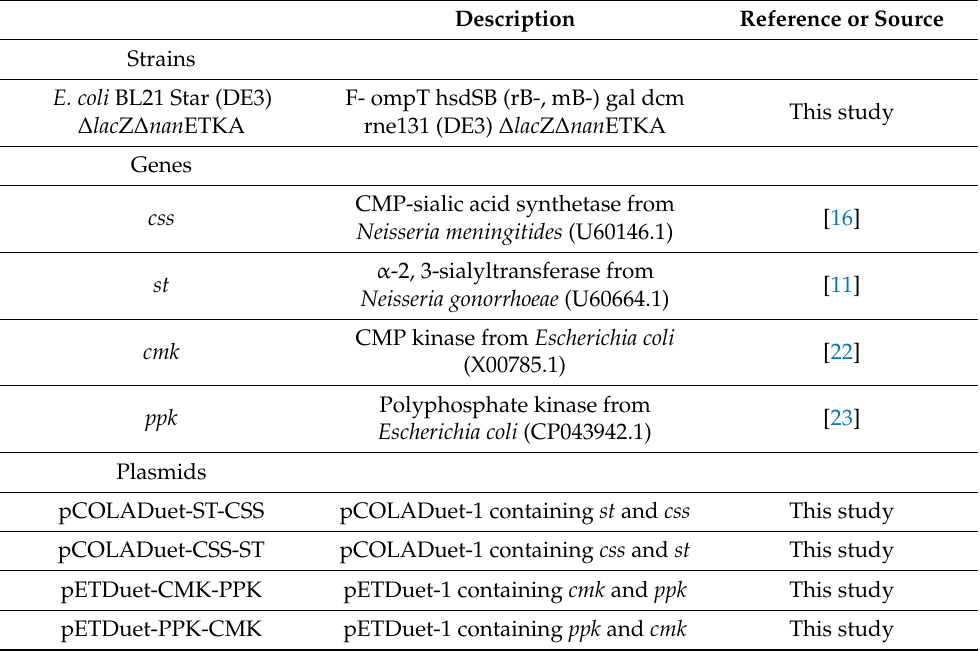
Table 1. Strains, genes, and plasmids used in the